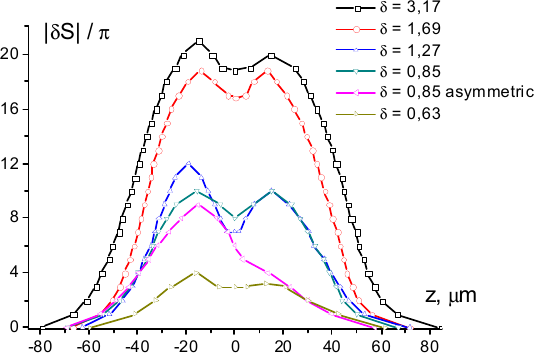
Figure 8. The phase shift reconstructed from the microphotographs shown in Figure 7. Lines are an eye-guide connecting the experimental points.